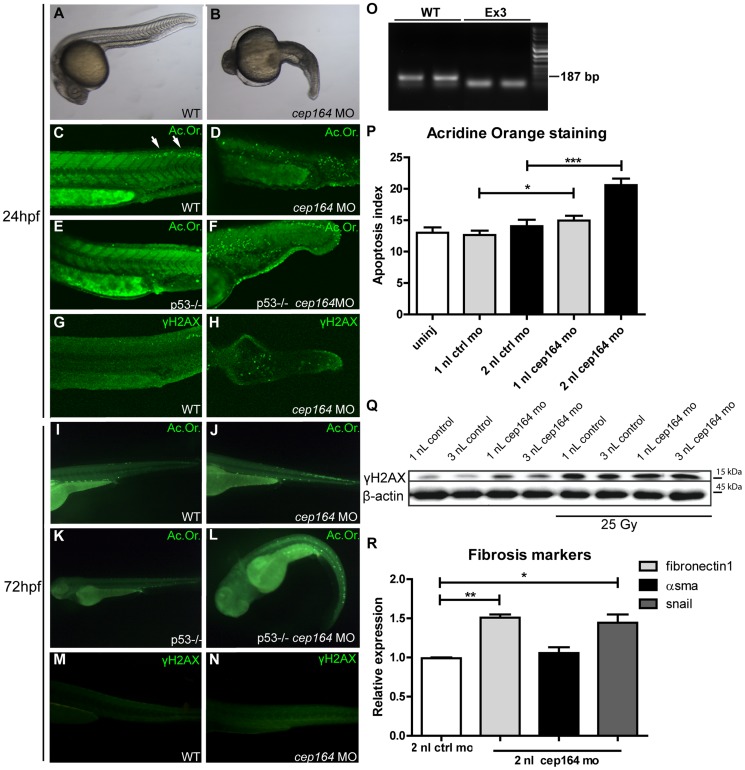
Apoptosis, DNA damage signaling and fibrosis in zebrafish.Zebrafish cep164 knockdown leads to developmental abnormalities associated with apoptosis and DNA damage. A cep164 morpholino targeting the exon 3 splice donor reduces wildtype mRNA (lanes WT) and results in a smaller cep164 RT-PCR product indicating an internal deletion (lanes Ex3) (O) was injected into 1–2 cell embryos. Compared to wild-type embryos at 24 hpf (A), morphant embryos (B) were stunted and displayed shorten body axis, body axis curvature, and edema. No cysts or other specific phenotypes were observed in the pronephros of morphant fish. Acridine orange staining revealed a low level of apoptosis in control injected WT (C) and p53 -/- embryos (E) restricted primarily to the posterior neural tube (arrows in C). cep164 knockdown induced widespread apoptosis (D) in the trunk and tail which was not affected by p53-deficiency as indicated by the cep164 knockdown-induced apoptosis in p53-/- mutants (n = 30) (F). Staining with γH2AX antibody revealed enhanced DNA damage signaling in cep164-deficient embryos (n = 10) (H) but not controls (G). Acridine orange staining (Ac. Or.) also revealed a low level of apoptosis in 72 hours post fertilization (hpf) control injected WT (I) and p53-/- embryos (K). cep164 knockdown induced widespread apoptosis (J) which was not affected by p53-deficiency as indicated by the cep164 knockdown-induced apoptosis in p53-/- mutants (n = 45) (L). Quantified acridine orange staining (Ac. Or.) reveals significantly increased apoptosis in WT zebrafish after cep164 knockdown (P). Student's t-test were used to calculate p-values (*<0.05, ***<0.001) (n = 70 in 4 experiments, error bars represent SEM). Staining with γH2AX antibody revealed enhanced DNA damage signaling in cep164-deficient embryos (N) but not control injected WT embryos (n = 10) (M). Western blot of γH2AX protein levels from lysates of 15 pooled embryos, two hours after irradiation with 25 Gy, show increased DNA damage signaling (Q). RT-QPCR reveals significant induction of snail and fibronectin1 in cep164 MO injected embryos at 32 hpf (R). mRNA expression from 12 pooled embryos is normalized to 2 nL control MO injected zebrafish. Student's t-test was used to calculate p-values (*<0.05, **<0.01).